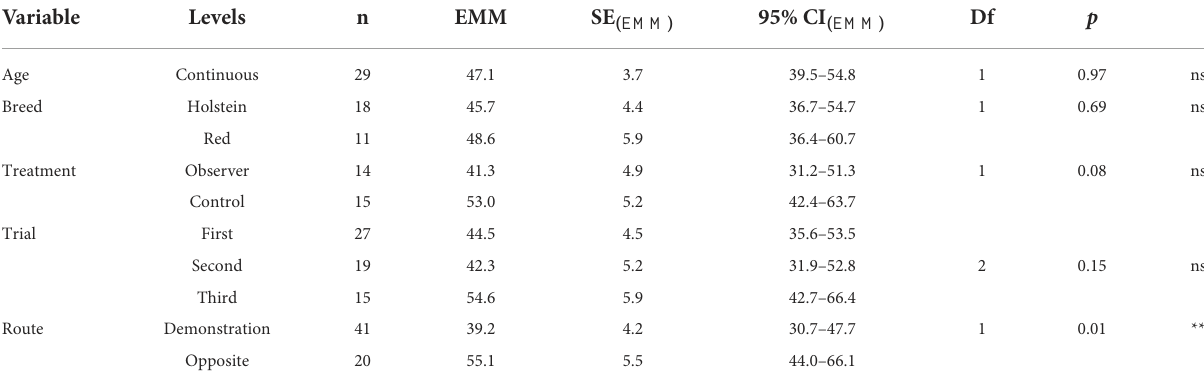
TABLE 3 Summary of the mixed-effects linear regression on latency to reach reward bucket in successful trials. Variable